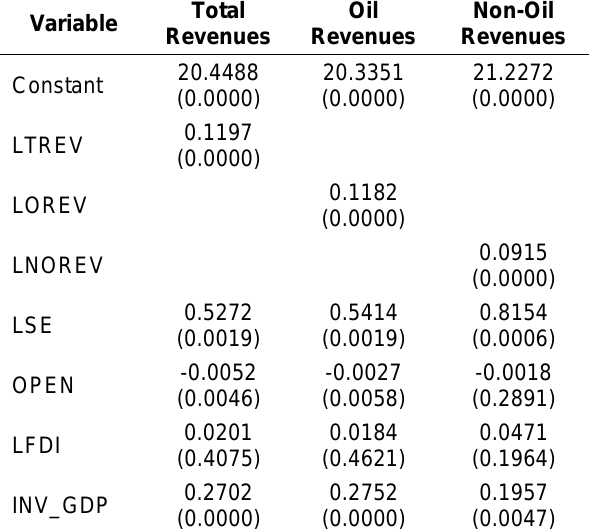
Table 5. Long-run Model Results. Dependent Variable: Real Gross Domestic Product